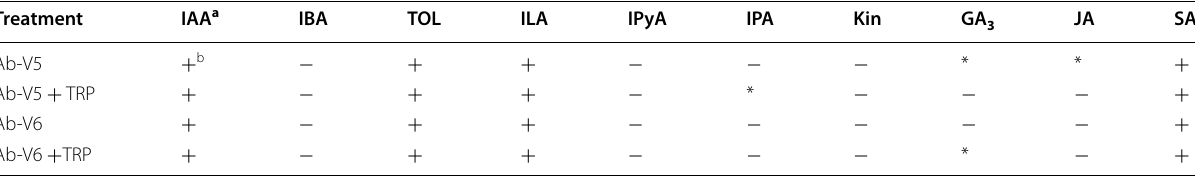
Table 3 Identification by ultrahigh-performance liquid chromatography-high-resolution mass spectrometry